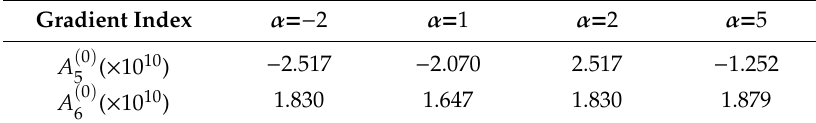
( 0 ) ( 0 ) in di ff erent gradient and A 6 5